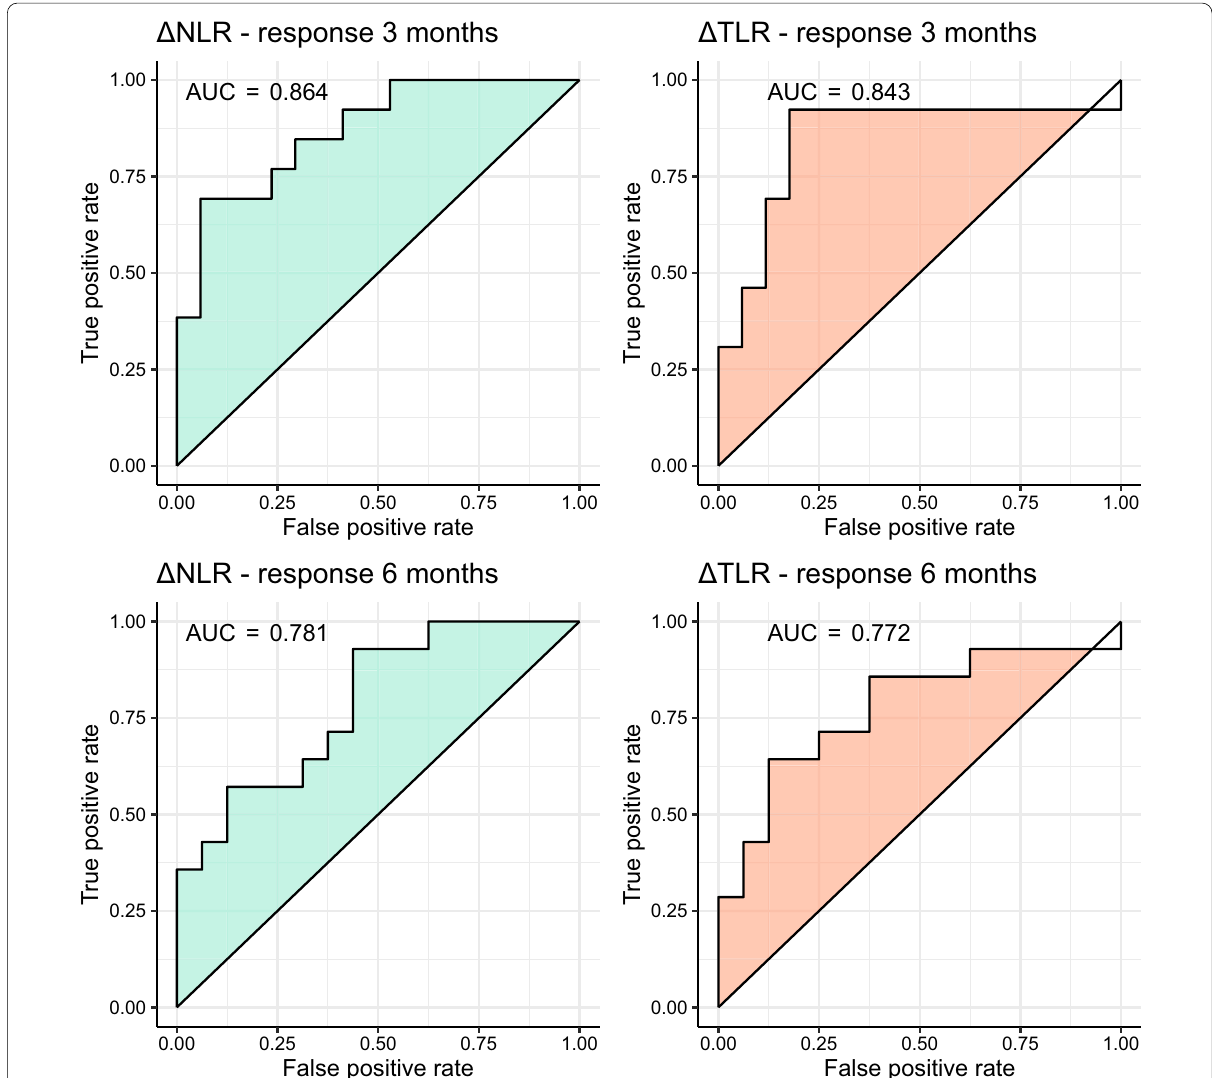
Fig. 4 ROC curves of relative change in NLR and TLR from baseline at 3-weeks follow-up in predicting objective response at 3 months (top row) and 6 months (bottom row), according to RECIST 1.1. AUC area under the